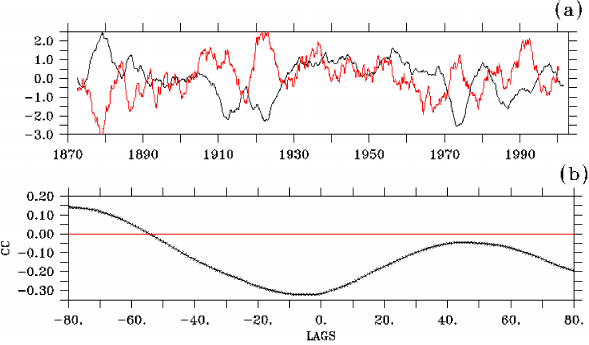
Figure 5 - (a) Standardized time series of the IHSST index (black) and NAO index (red) smoothed with a 5-year running mean; (b) Lagged correlation between the two time-series shown in (a). Correlation coefficients are significant at 95% and indicate the phase relationship (NAO lags IHSST). The highest correlation of -0.36 occurs at 5months lag, with IHSST leading. lags are in months.